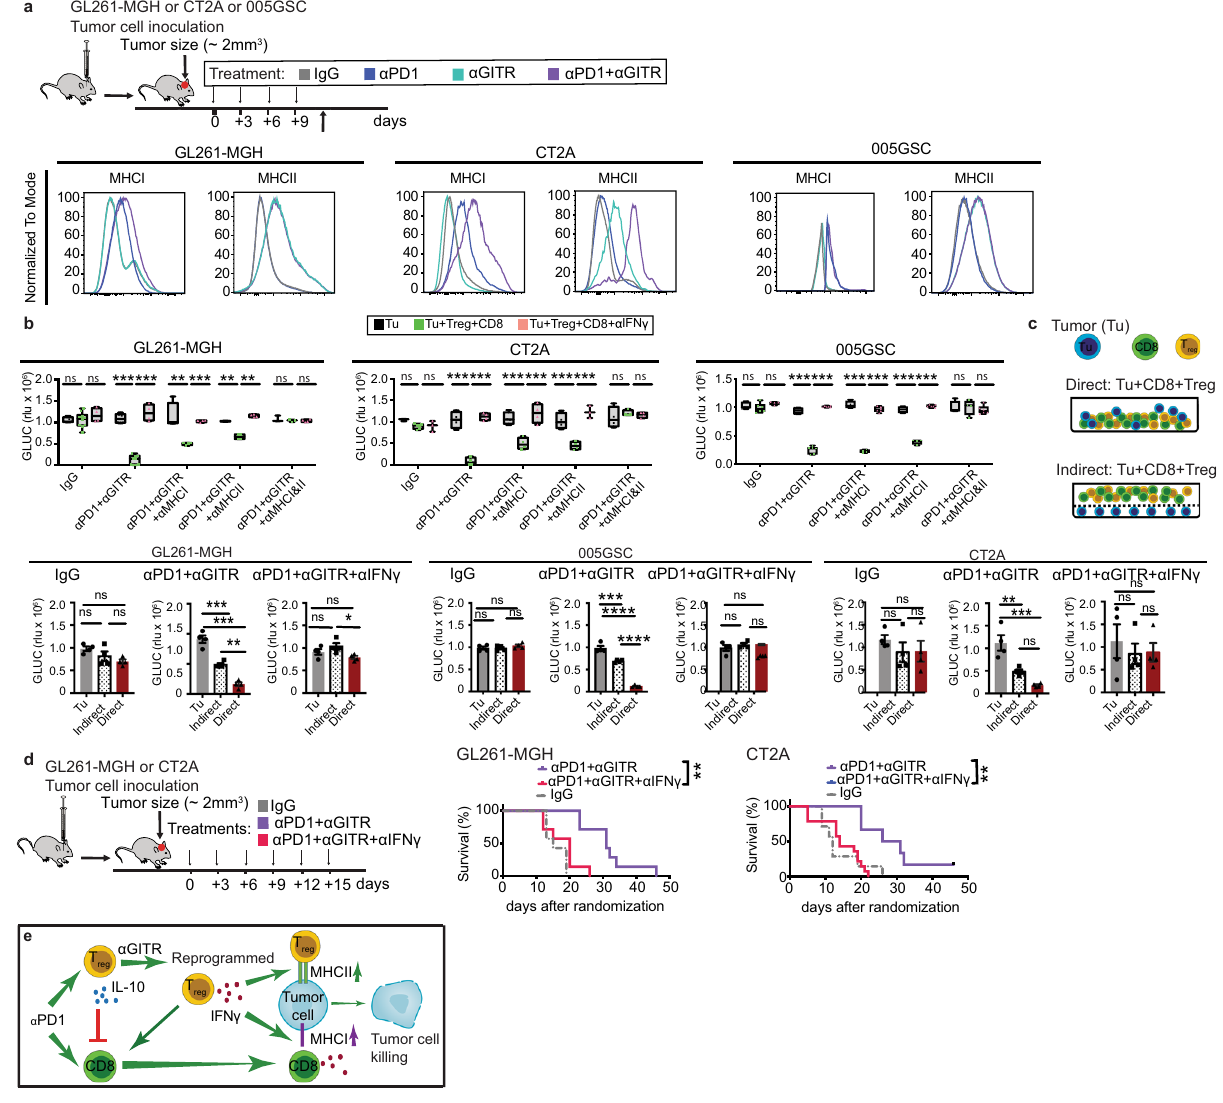
Fig. 5 MHC dependent recognition and IFN γ -mediated cytolysis are required for antitumor activity of reprogrammed Treg cells and re-activated CD8 T cells. a Schematic representation of the experimental protocol. Mice bearing orthotopic GBM tumors (GL261-MGH, 005GSC or CT2A, size ~2 mm 3 ) were treated with 4 doses of (i) IgG2a, (ii) α PD1, (iii) α GITR, or (iv) α GITR + α PD1 (250 µ g/mice for each antibody), and tumor cells were analyzed for expression of MHCI and MHCII by FACS ( n = 6). Histograms represent the expression level of each molecule after therapy. b Treg cells and CD8 T cells were sorted from spleens of healthy donor mice ( n = 6 per condition). GL261-MGH, CT2A, or 005GSC tumor cells (1 × 10 3 cells) were co-cultured with both Treg cells and CD8 T cells at a 1:10 ratio for 48 h. GLUC activity in the cell culture media was measured and used as a surrogate marker for tumor